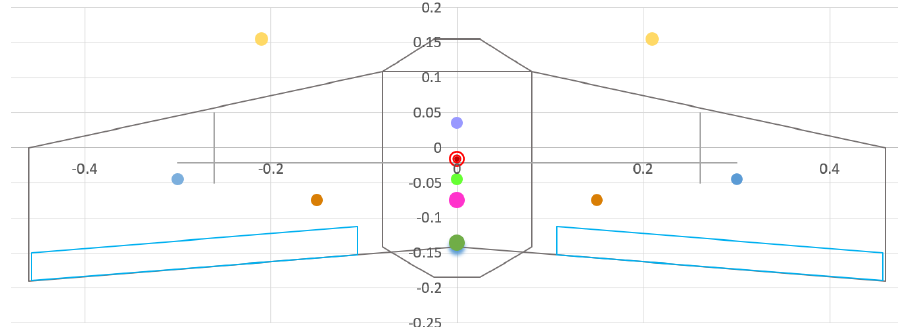
Figure 5. Top view of global tail-sitter scheme.